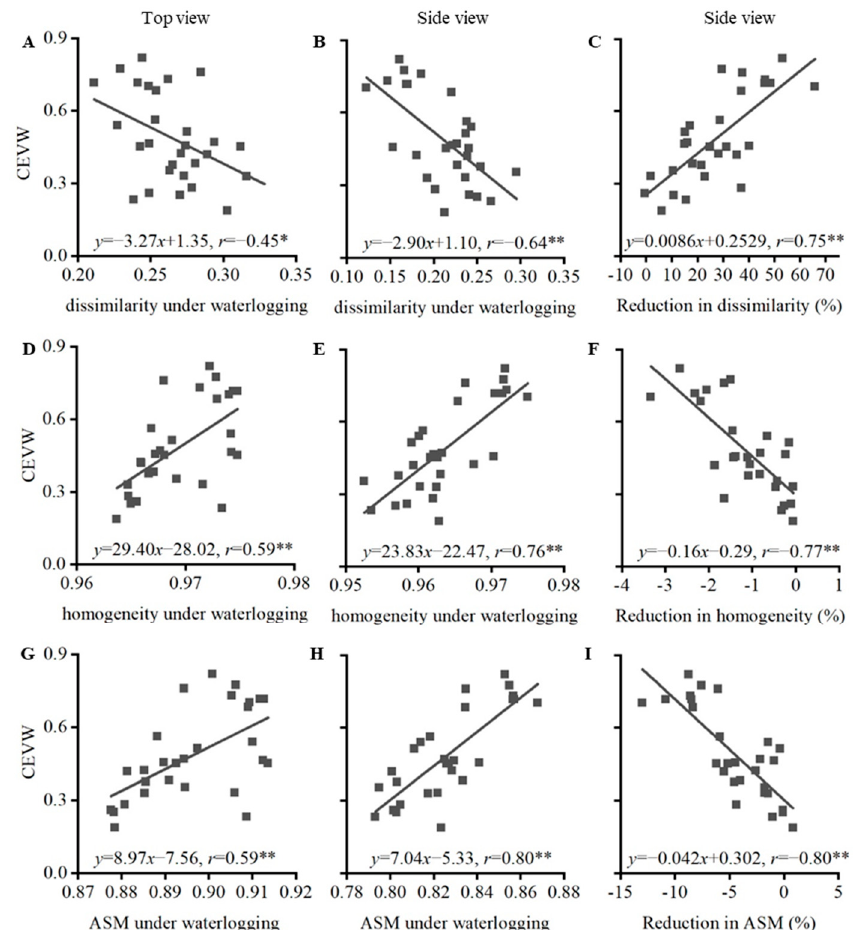
Figure 4. Relationships of CEVW with dissimilarity, homogeneity, and ASM extracted from images of the top view ( A , D , G ) and side view ( B , E , H ) under waterlogging and their percentage reductions ( C , F , I ). * and ** indicate significance at the 0.05 and 0.01 probability levels, respectively.